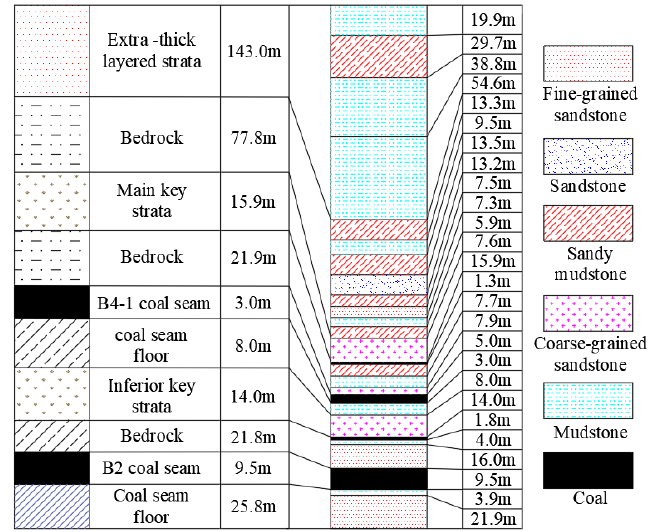
Figure 1. Schematic diagram of the stratum structure of Kuangou coal mine. The W1123 fully mechanized top-coal caving face is arranged in the west wing of the No.1 mining area of the B2 coal seam, which is located at level 1255 of the mine. Its ex- ploitable strike length is 1468 m, and its inclined length is 192 m. The designed mining height is 3.2 m, the coal caving thickness is 6.3 m, the mining–caving ratio is 1:1.97, and the average inclination angle of the working face is 14. The horizontal elevation of the transportation lane in the W1123 fully mechanized top-coal caving face section is +1321 m to +1327 m, the horizontal elevation of the return air lane in the section is +1365 m to +1375 m, and the elevation of the working face is +1660 m to +1820 m. At the horizontal elevation of +1343 m to +1346 m, the technical roadway is arranged. The main functions of the road- way are mine pressure prevention, gas prevention, and the air intake at the working face, with a length of 1469 m. On the working face, the upper 50 m of the 13 to 745 m section of the transportation lane connecting the lane to the west is the W1145 goaf of the B41 coal seam, and the lower 15 m of the same coal seam is the W1121 goaf. The lower part of the working face is the B1 solid coal seam. Figure 2 shows the layout plan of the working face roadway.